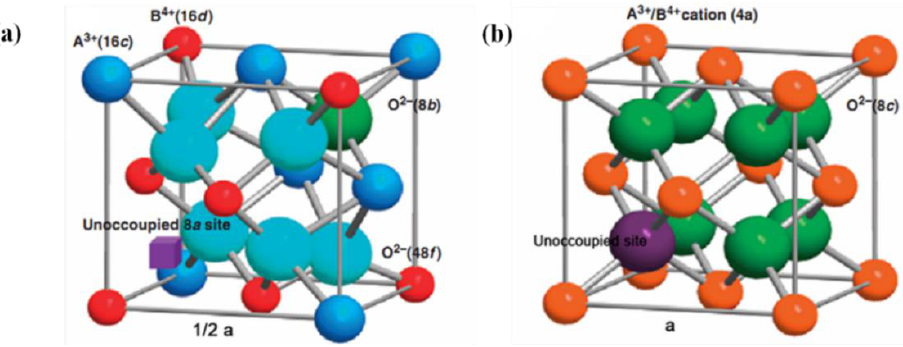
Figure 7. ( a ) Structure of pyrochlore (1/8 unit cell), ( b ) Structure defective fluorite. Reproduced with permission from [83] . permission from